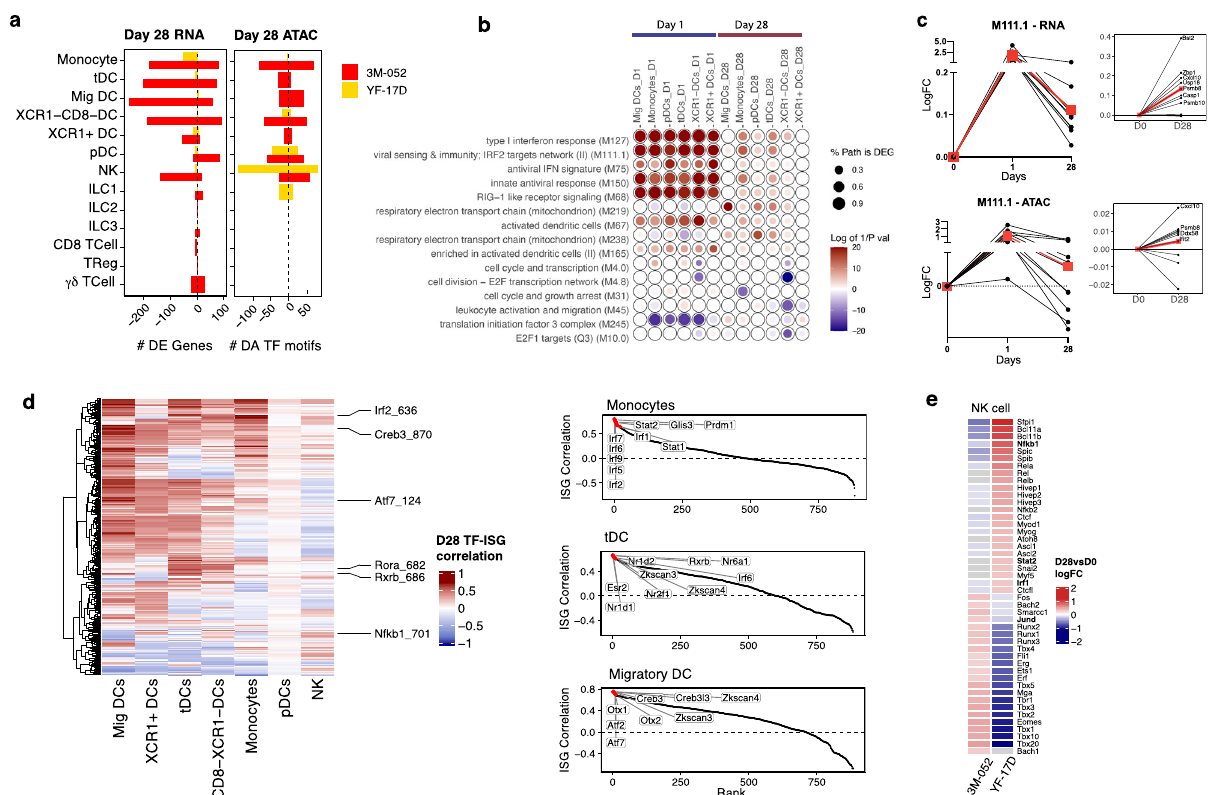
Fig. 5 3M-052-Alum/OVA induces long-lasting changes in innate immune cells that persisted up to Day 28. a Number of signi fi cantly expressed (RNA) genes that remain up or downregulated compared to baseline (FDR < 0.05 absolute logFC > 0.1) and the total number of signi fi cantly accessible (ATAC) motifs at day 28. b BTMs signi fi cantly enriched (FDR < 0.001) after 1- and 28-days post-immunization with 3M-052-Alum/OVA across dLN innate immune cells. Overrepresentation analysis of the differentially expressed genes was used to determine signi fi cance. c Temporal expression pattern of all genes within modules M111.1 and M111.0 (viral sensing & immunity; IRF2 targets network) in both RNA (left panels) and ATAC (right panels, red line, and square represent the mean fold change). d Heatmap of TF-ISG correlation in each cell subset. Pearson correlation is shown here (left). Rank plots of TF motifs that correlate with I fi t3 expression in each cell type (right). e Top differentially accessibile TF motifs at day 28 in YF-17D compared to 3M-052- Alum/OVA (FDR < 0.05 absolute logFC > TF motif z-score with I fi t3 gene accessibility score within single cells at day 28 (Fig. 5d). Strikingly, we found that Irf2 and Stat2